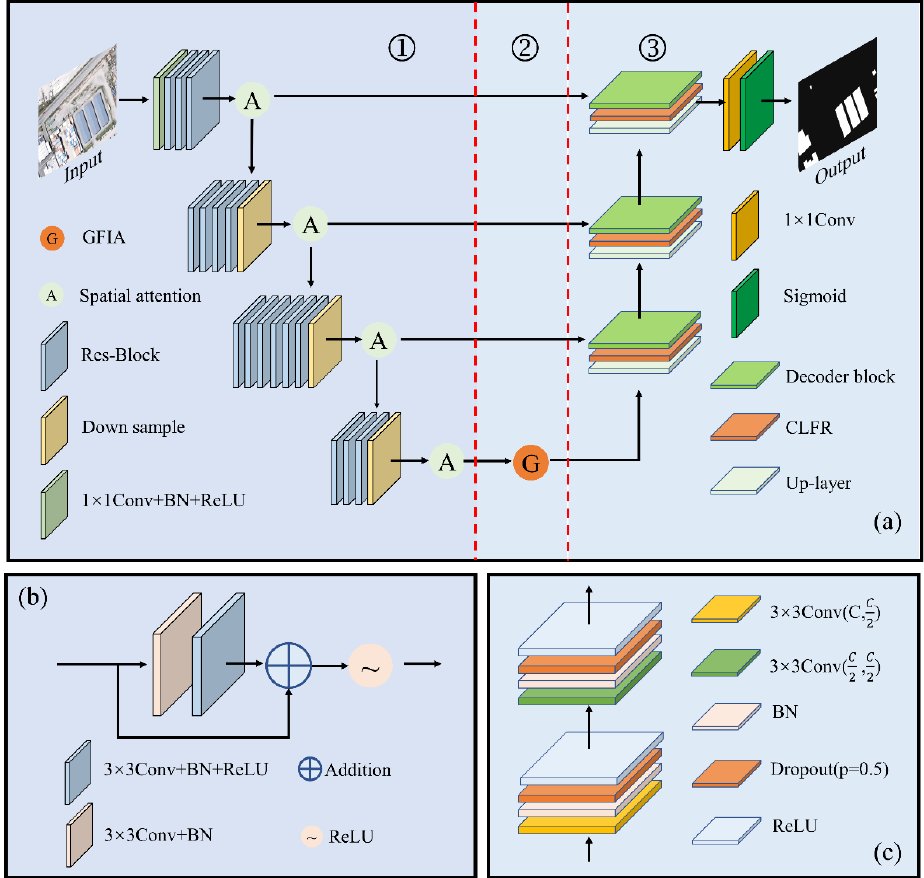
Figure 1. Overall of the proposed framework. ( a ) Structure of the B-FGC-Net, in which ① , ② , and ③ denote the encoder, the GFIA module, and the decoder, respectively, Down sample denotes downsampling, Up-layer denotes upsampling; ( b ) Res-Block; ( c ) Decoder-Block, where C denotes the number of channels of the feature map, and p is the probability of an element being zeroed. The addition and ReLU represent the pixel addition and the Rectified Linear Unit, respectively. The 1 × 1 and 3 × 3 denote the convolution kernel